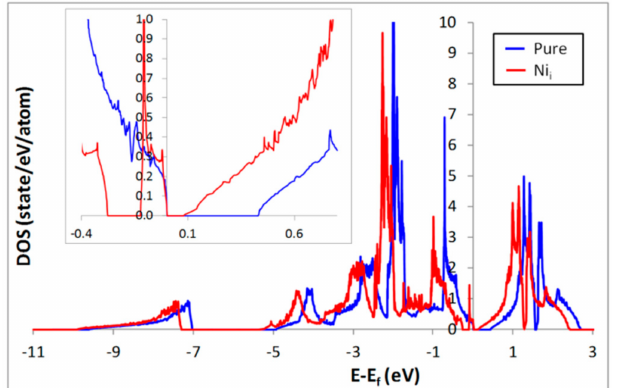
Figure 1. DOS of NiTiSn calculated in GGA for the pure compound and for the compound containing 1% of interstitial nickel atoms (Ni i